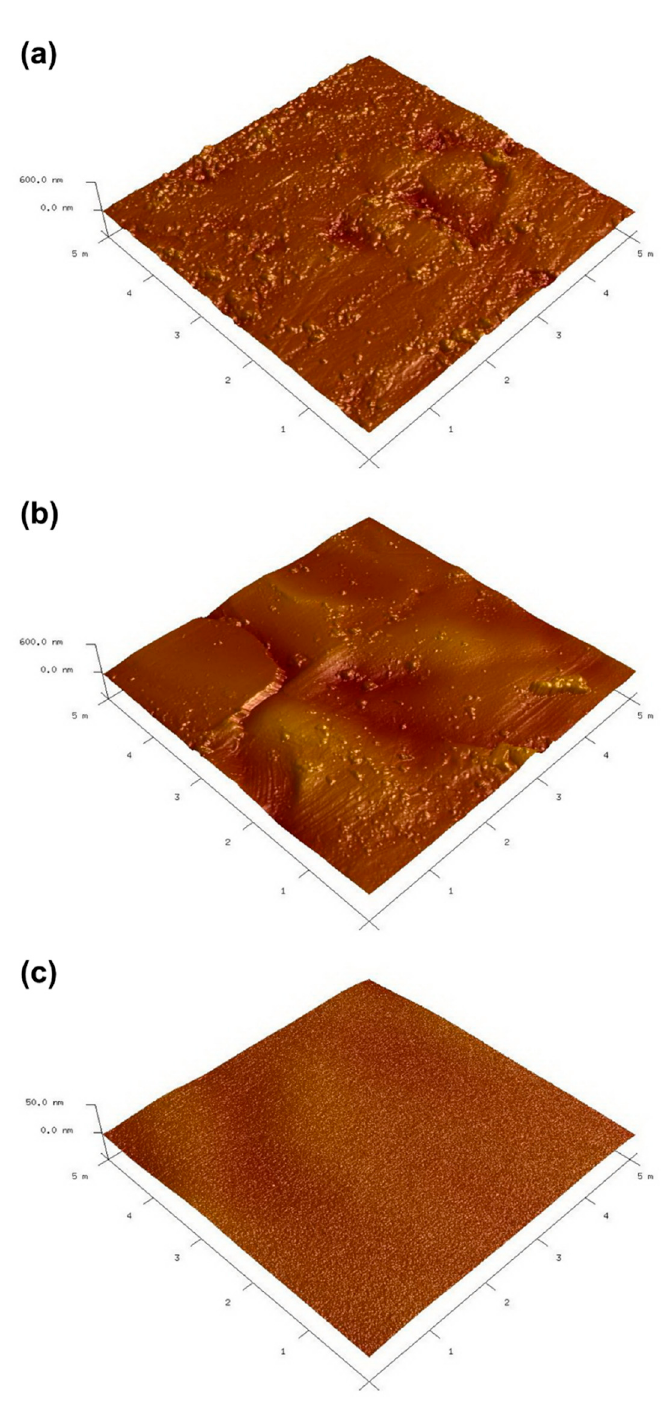
Figure 3. Surface topographic micrographs for ( a ) pristine SS substrate, ( b ) SS-BP, and ( c ) SS-BP-MPC composites.